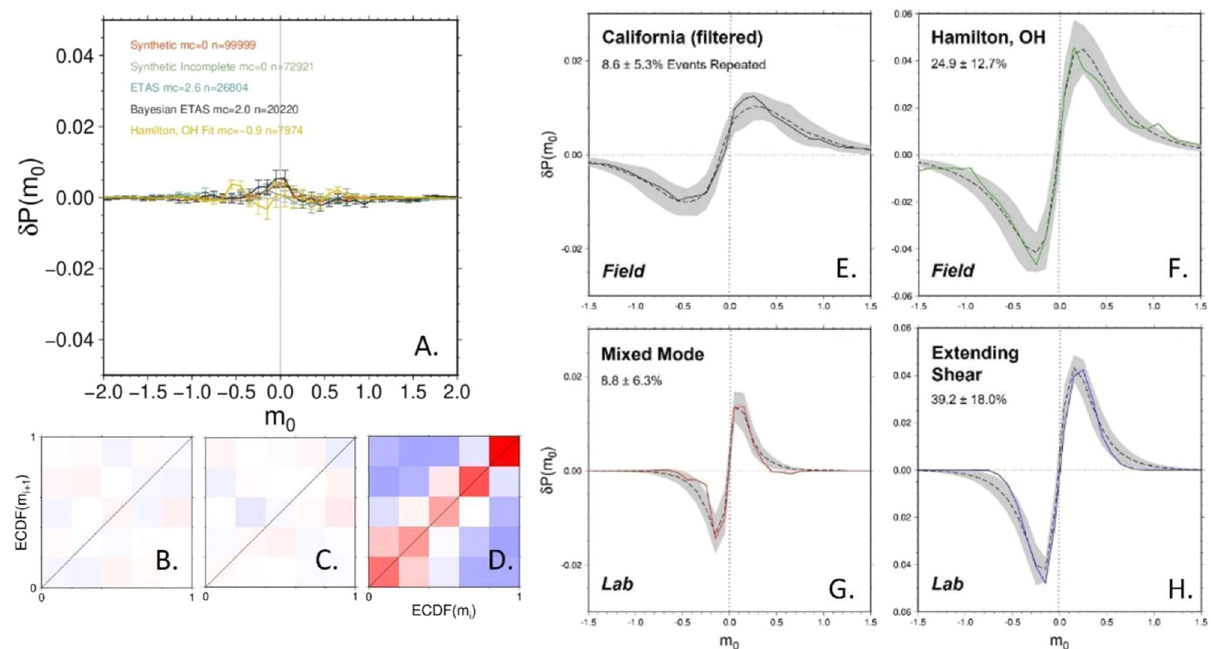
Fig. 6 | Key results of synthetic catalog analysis. A Comparison of cumulative distribution for synthetic catalogs generated with different approaches, including adding arti fi cial incompleteness to the stochastic catalog and tuning the ETAS parameters to the Hamilton, OH catalog. ECDF results for the B ETAS catalog fi t to Hamilton parameters, C stochastic catalog with incompleteness added, and D 22% repeating events added to the ETAS catalog. Magnitude clustering patterns